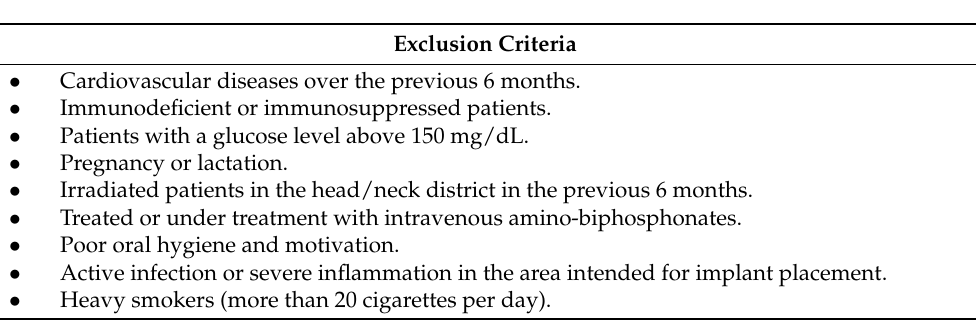
Table 2. Exclusion criteria.